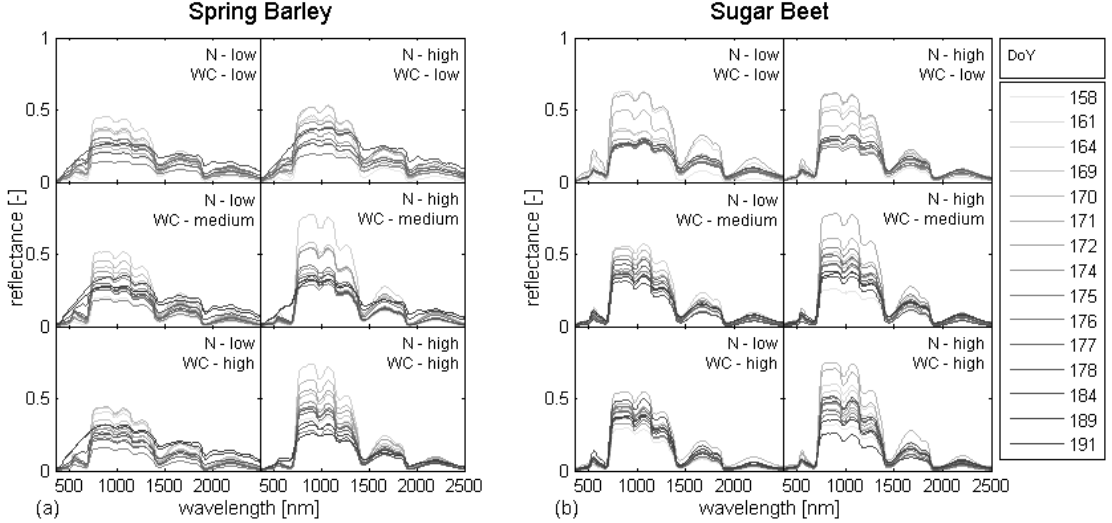
Figure 2. Temporal dynamics of spectral properties of Spring Barley (a) and Sugar Beet (b) , plotted with regards to applied WC and N treatments (indicated in an upper right corner of all plots), during the BL 2008